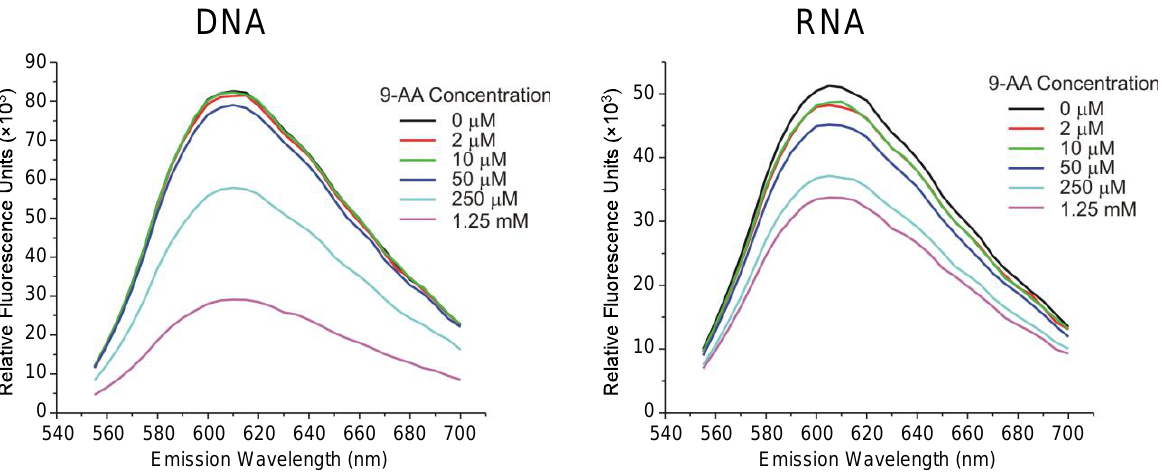
Figure 5. Fluorescent intercalator displacement. Emission spectra of EtBr bound to salmon sperm DNA and baker ’ s yeast RNA in the presence of increasing concentrations of 9AA; λex = 525 nm .